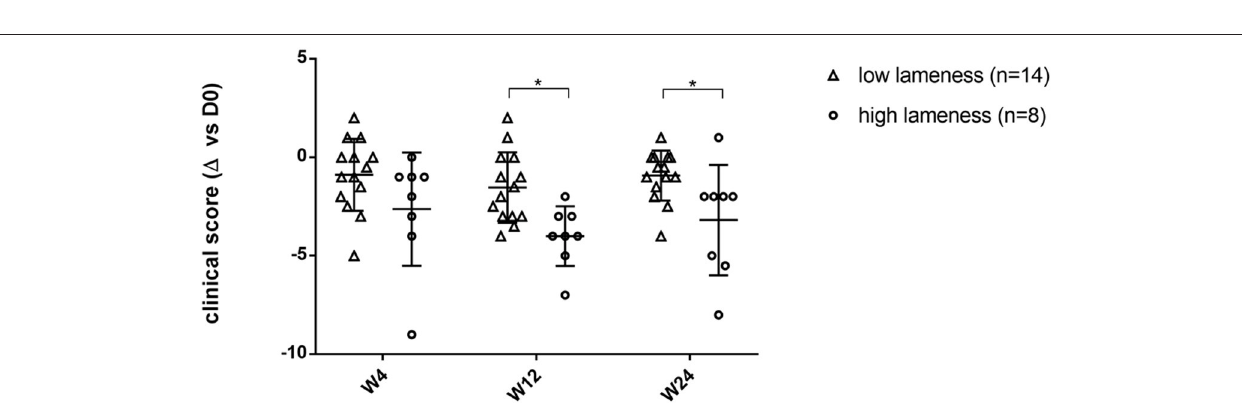
FIGURE 3 | Comparison of the clinical score evolution between more lame limbs group and less lame limbs group after treatment during the 6-month follow-up period. * Significant difference ( p < 0.05) between low lameness and high lameness groups at each time point. This figure shows that the clinical score evolution is significantly more changed in joints severely